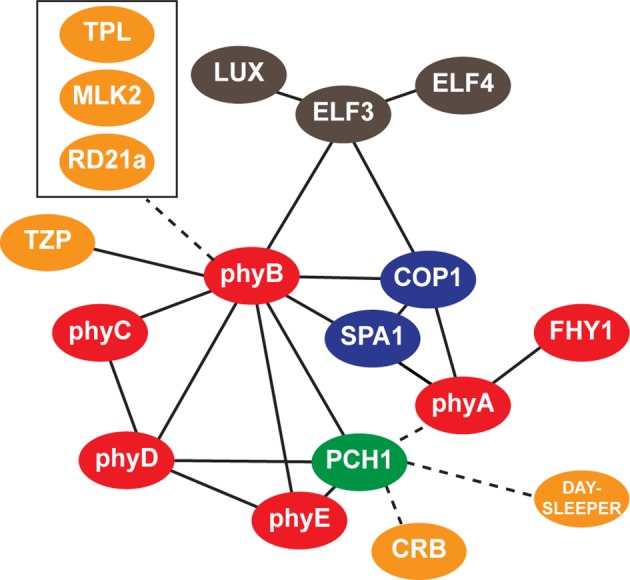
Interaction map of PCH1-associated proteins.An updated interaction map from previous described (Huang et al., 2015), which integrate our AP-MS and protein-protein interaction data to illustrate both directly and indirectly interacting proteins that co-precipitate with PCH1. Solid lines indicate direct interactions determined in this study or previously defined, while dotted lines indicate association.